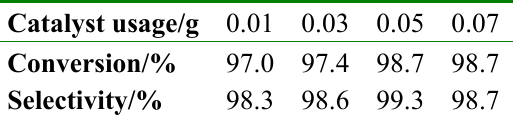
Table 2. The effect of the catalyst amount on the yield.